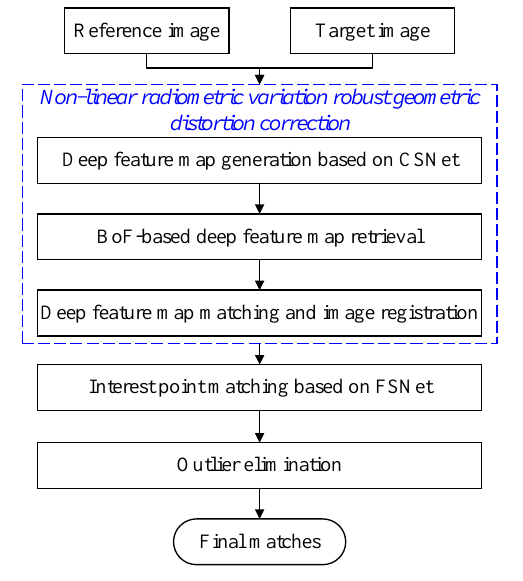
Figure 4. Flowchart of the proposed multimodal image matching method. The steps in the blue dotted box are designed to make the matching method robust to image geometric